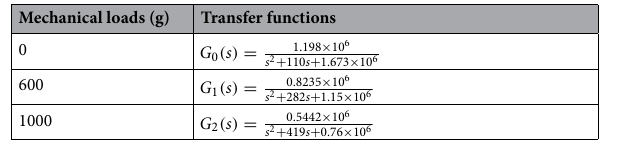
Table 1. System model under different mechanical loads.